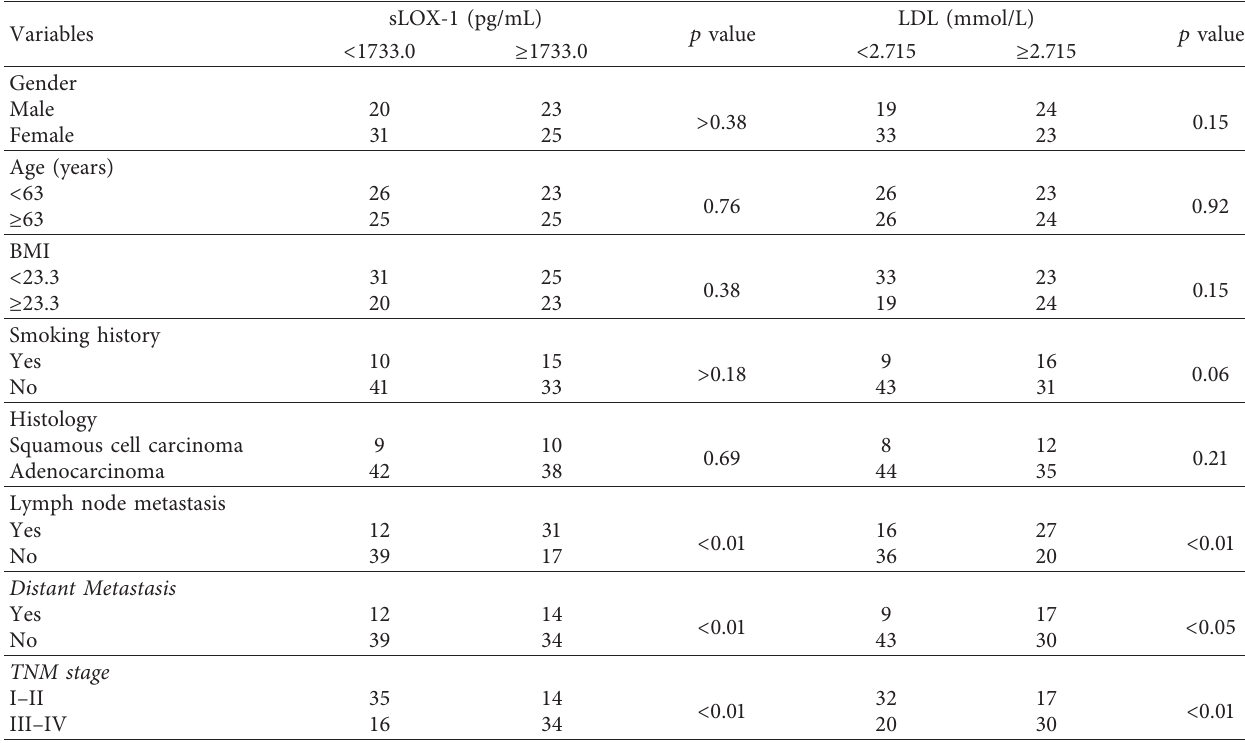
Figure 2: Correlation of serum sLOX-1 with blood lipid LDL. Table 4: Correlation between sLOX-1, LDL, and clinicopathological characteristics of NSCLC patients.